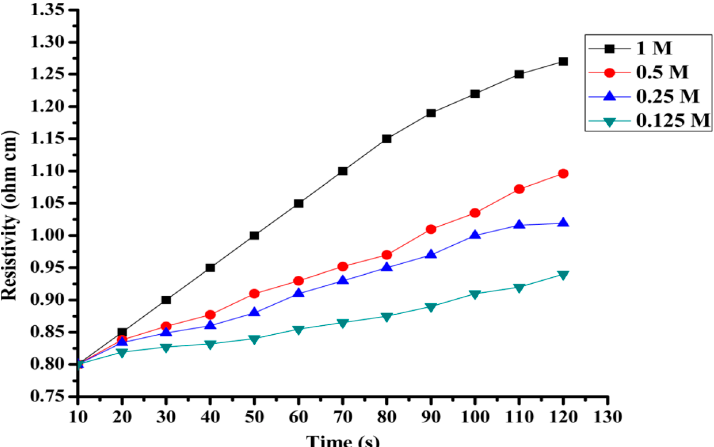
Figure 22. Effect on the resistivity of PCz/TiO 2 nanocomposite on exposure to different concentrations of ammonia with respect to time. Reprinted with permission from Shakir et al. [100]. Copyright (2014) American Chemical Society.